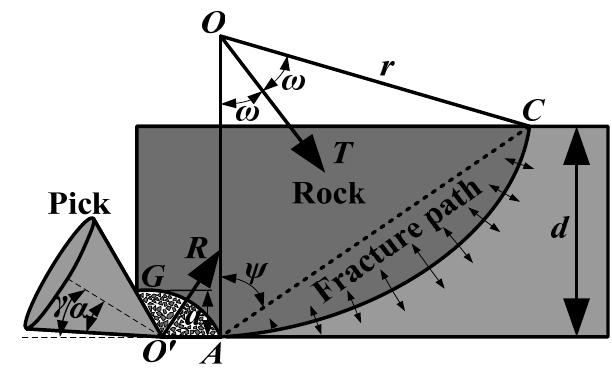
Figure 2: Vertical mechanical model of rock